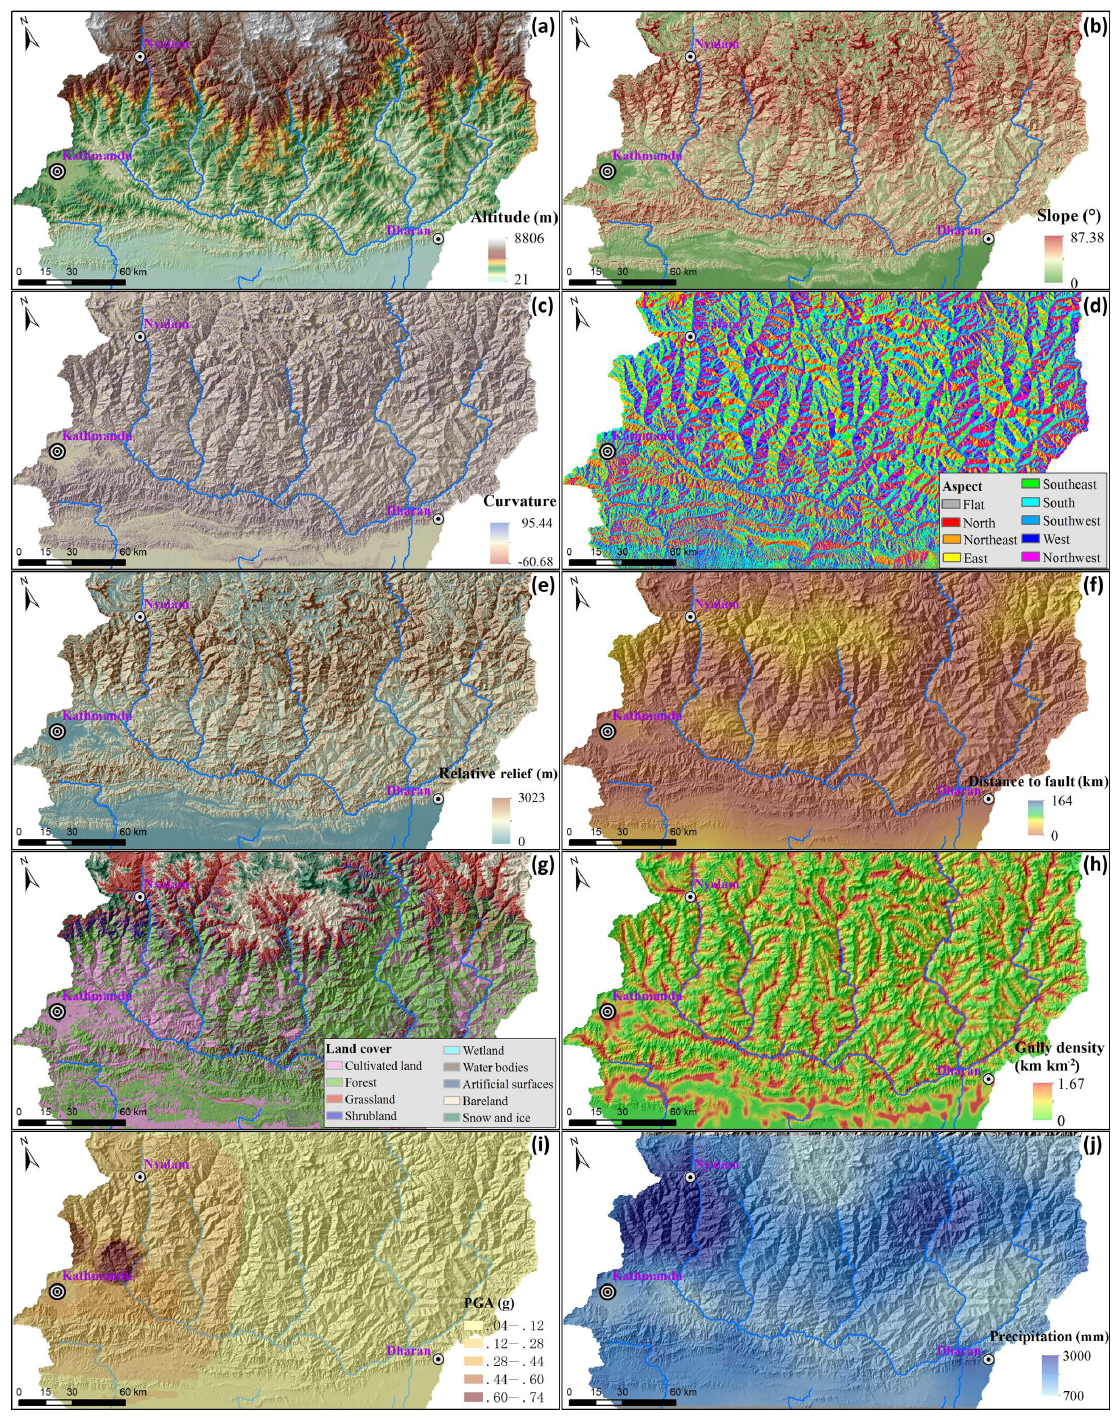
Figure 7. Landslide susceptibility assessment factors: (a) altitude (data source: JAXA/METI ALOS PALSAR DEM); (b) slope gradient; (c) slope curvature; (d) slope direction; (e) relative relief; (f) distance to fault; (g) land cover; (h) drainage density; (i) peak ground acceleration of the 2015 Gorkha earthquake (peak-ground-acceleration data for the Gorkha earthquake were obtained from USGS ShakeMap, which was designed as a rapid response tool to portray the extent and variation of ground shaking throughout the affected region immediately following significant earthquakes); (j) average total monsoon precipitation. (ICIMOD and the National Meteorological information Center of China. These data are the average precipitation for the period 1991–2010, for the monsoon season from June to October.)